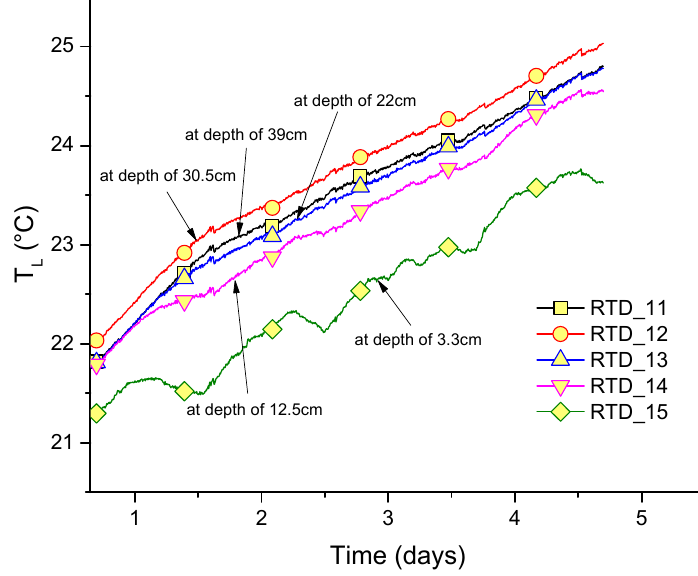
Figure 5. Time-history of the temperature on the left side of the pile.